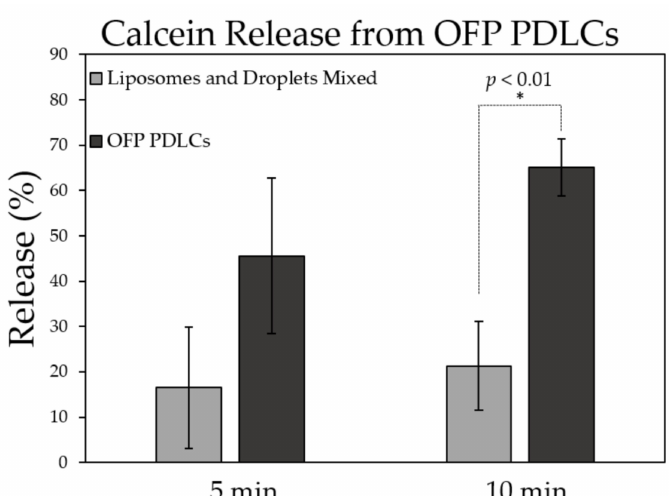
Figure 8. Calcein release from octafluoropropane (OFP) PDLCs during ultrasound exposure at 37 ◦ C. Calcein release was significantly higher after 10 min US exposure (* p < 0.01) compared to equivalent concentrations of droplets and liposomes mixed in solution. N = 3 per